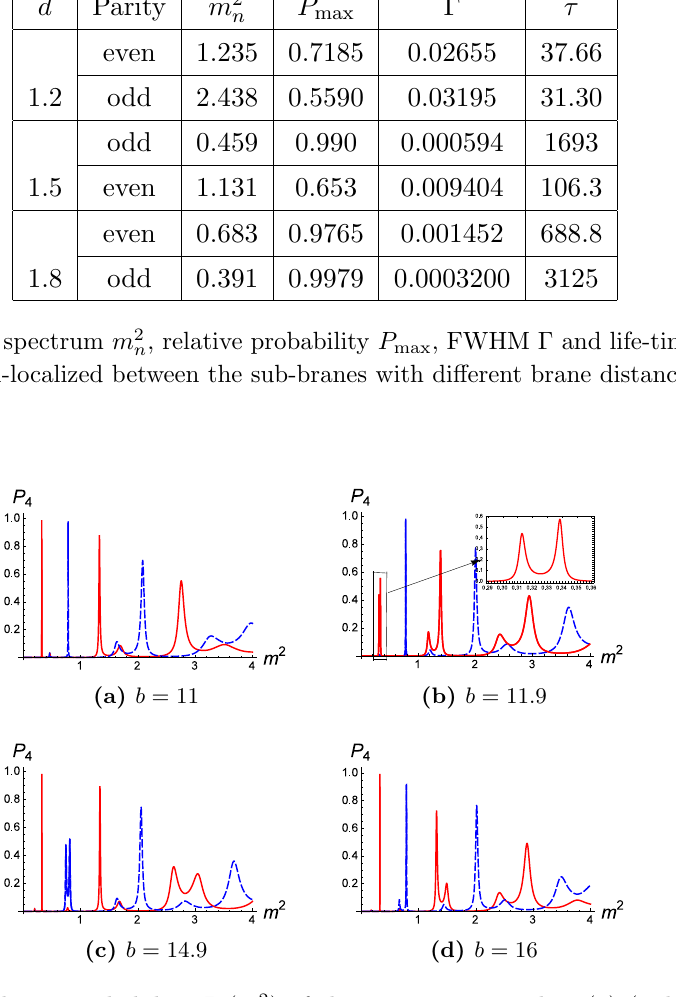
Figure 13. The relative probability P 4 ( m 2 ) of the even parity mode t e ( z ) (red solid lines) and the odd parity mode t o ( z ) (blue dashed lines) quasi-localized between the sub-branes for di(cid:11)erent values of the brane thickness b . The parameters are set to k = 1, d = 2 : 3, and b = 11 ; 11 : 9 ; 14 : 9 ;